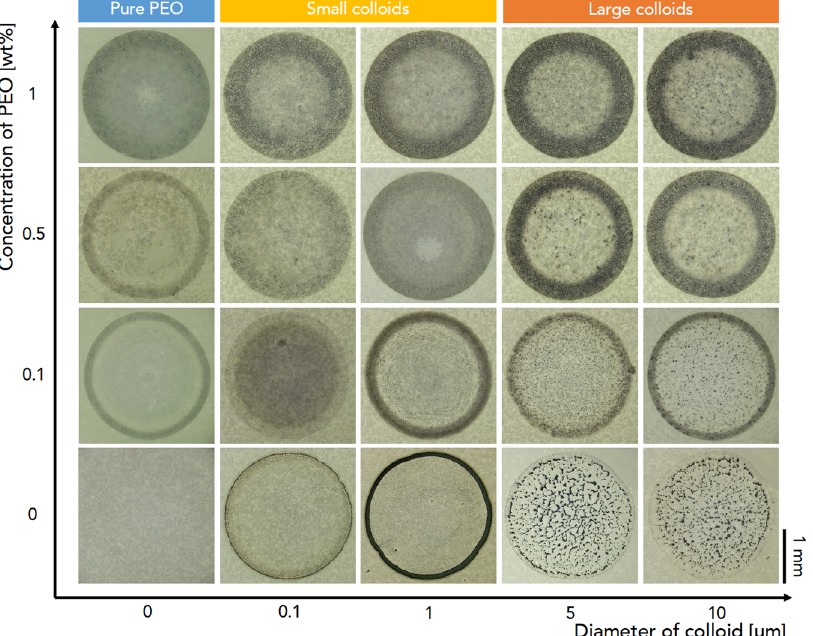
Figure 1. A phase diagram for drying-mediated patterns. Deposit patterns were taken by varying colloid size (100 nm ~ 10 μ m in diameter) and polymer concentration (0~1.0 wt%) in a model colloid-polymer system, consisting of poly(methyl methacrylate) (PMMA) (PMMA concentration is fixed as 0.1% (1 mg/ml)) colloid and poly(ethylene oxide) (PEO) polymer (the viscosity average molecular weight M v = 1,000 kg/mol) suspended in water. Deep interpretation about patterns is described in the